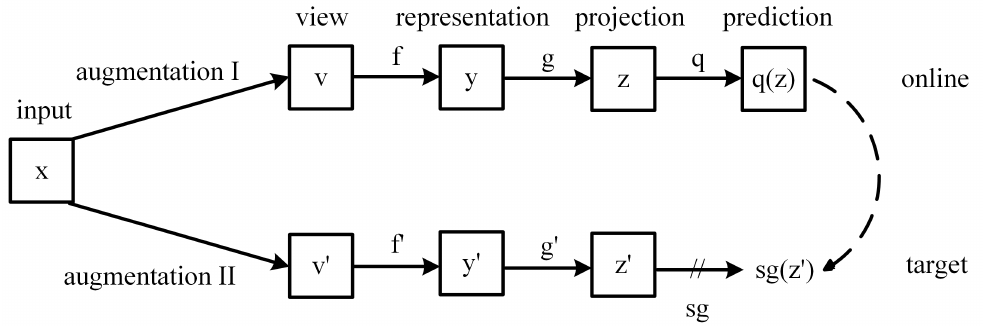
Figure 1. The architecture of the BYOL